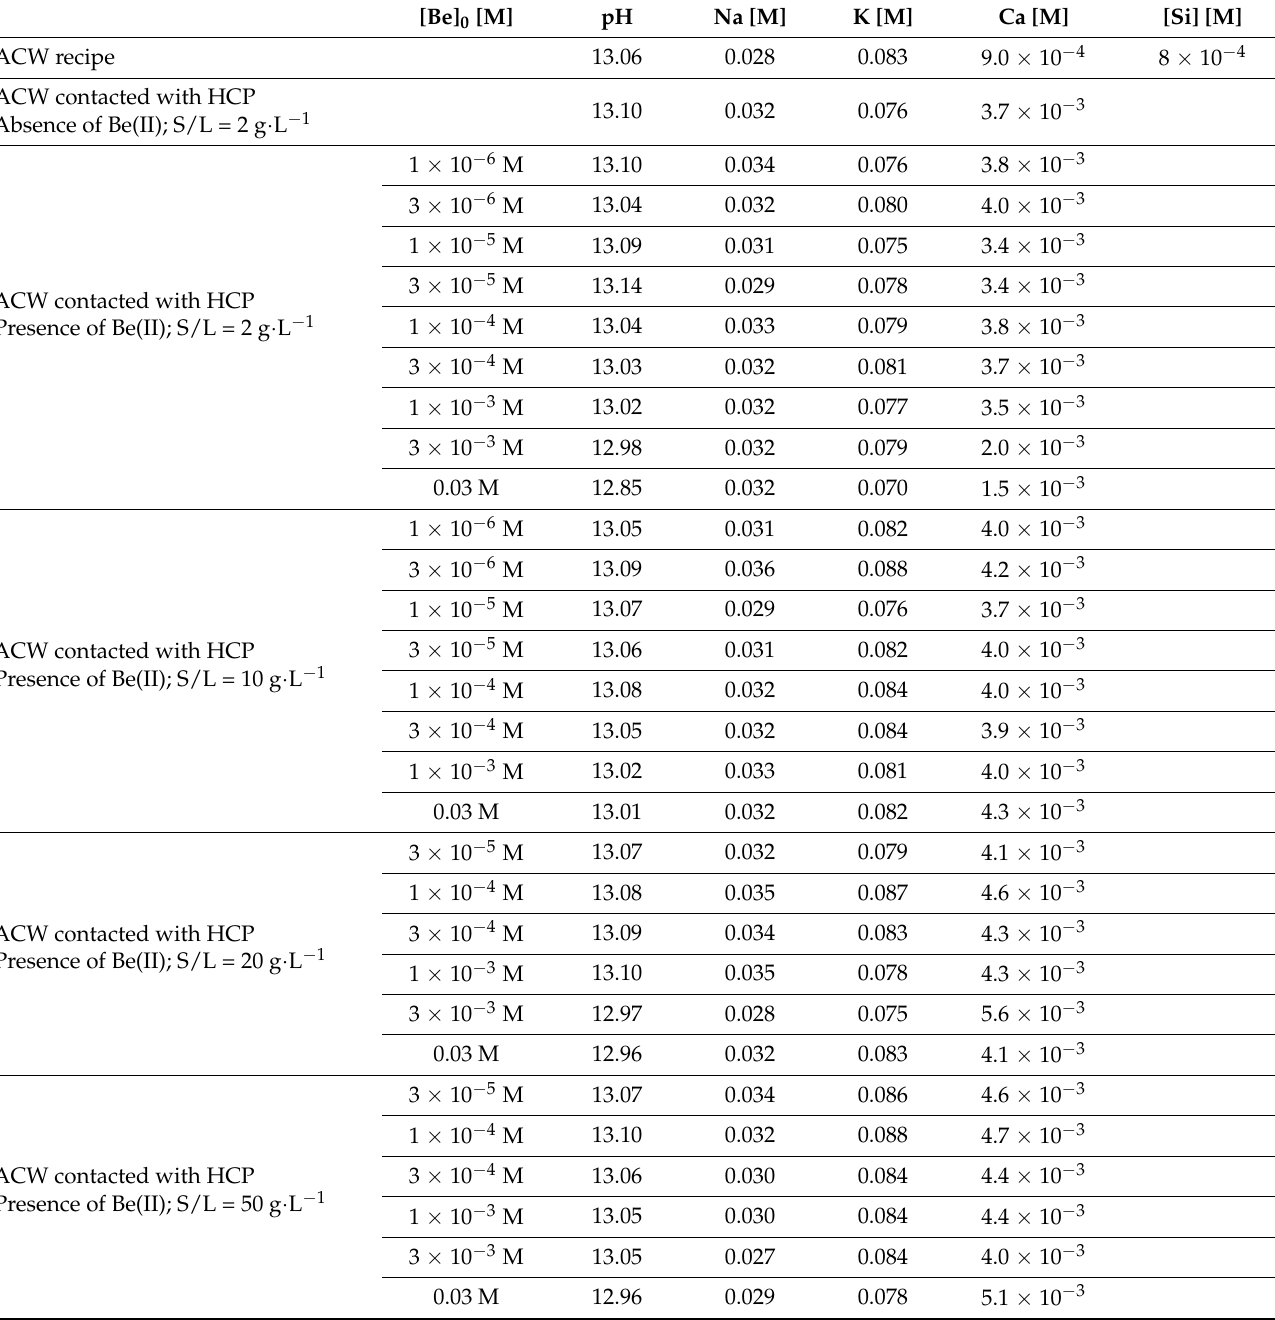
Table 1. Aqueous composition (pH, [Na], [K], [Ca], [Si]) of the pore water in contact with HCP (deg. stage I) before and after equilibration with beryllium. Related uncertainties are ± 0.10 for pH measurements and ± 2–30% for the measured